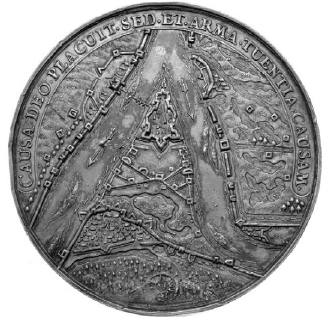
Fig. 3. The fortress of Głowa Gdańska